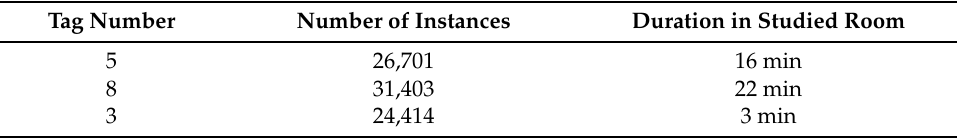
Table 3. Description of subjects for DS2 .